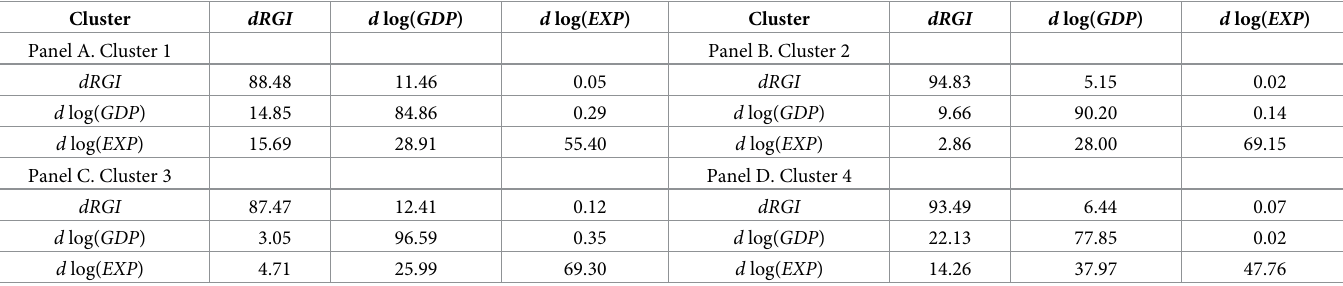
Table 9. Variance decomposition results under different country categories (unit: %). Cluster dRGI d log( GDP ) d log( EXP ) Cluster dRGI d log( GDP ) d log( EXP ) Panel A. Cluster 1 Panel B. Cluster 2 dRGI 88.48 11.46 0.05 d log( GDP ) 14.85 d log( EXP ) 15.69 69.15 Panel C. Cluster 3 Panel D. Cluster 4 dRGI 87.47 12.41 0.12 d log( GDP ) 3.05 96.59 d log( EXP )